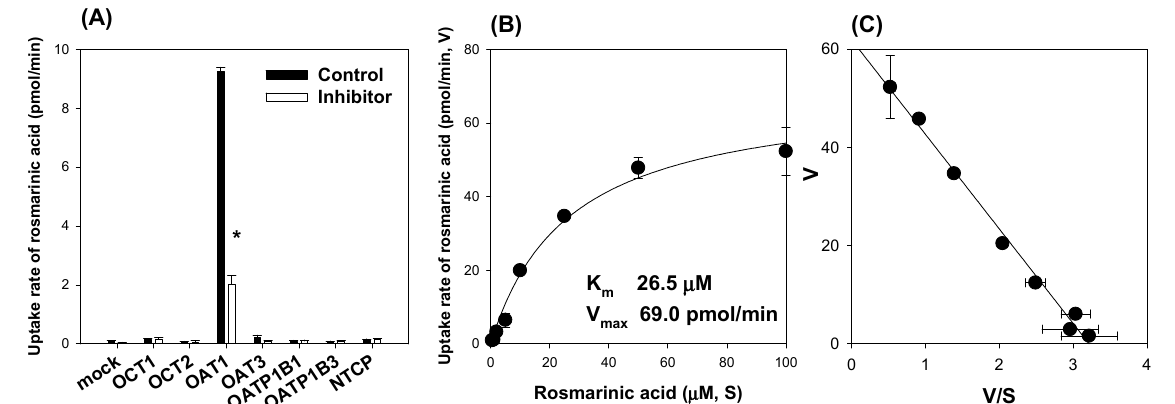
Figure 3. ( A ) The uptake of 10 µ M rosmarinic acid into HEK293-mock cells and HEK293 cells overexpressing OCT1, OCT2, OAT1, OAT3, OATP1B1, OATP1B3, and NTCP transporters, was measured for 5 min. The uptake rate of rosmarinic acid in the presence ( ◻ ) of representative inhibitors such as tetraethylammonium (10 mM) for OCT1 and OCT2, probenecid (50 μ M) for OAT1 and OAT3, rifampin (50 μ M) for OATP1B1 and OATP1B3, and cyclosporin A (20 μ M) for Na + /taurocholate cotransporting polypeptide (NTCP) was compared with that in the absence of inhibitors ( ◼ ). ( B ) The concentration-dependent uptake of rosmarinic acid into HEK293-mock and -OAT1 cells was measured for 5 min in the concentration range of rosmarinic acid (0.5–100 μ M). The OAT1-mediated uptake of rosmarinic acid was obtained by subtracting the uptake of rosmarinic acid in HEK293-mock cells from that in HEK293-OAT1 cells. ( C ) Eadie–Hofstee transformation of the OAT1-mediated uptake of rosmarinic acid. V indicated the uptake rate of rosmarinic acid and S indicated rosmarinic acid concentration. Each data point represents the mean ± standard deviation ( n = 3). * p < 0.05 compared with control group.